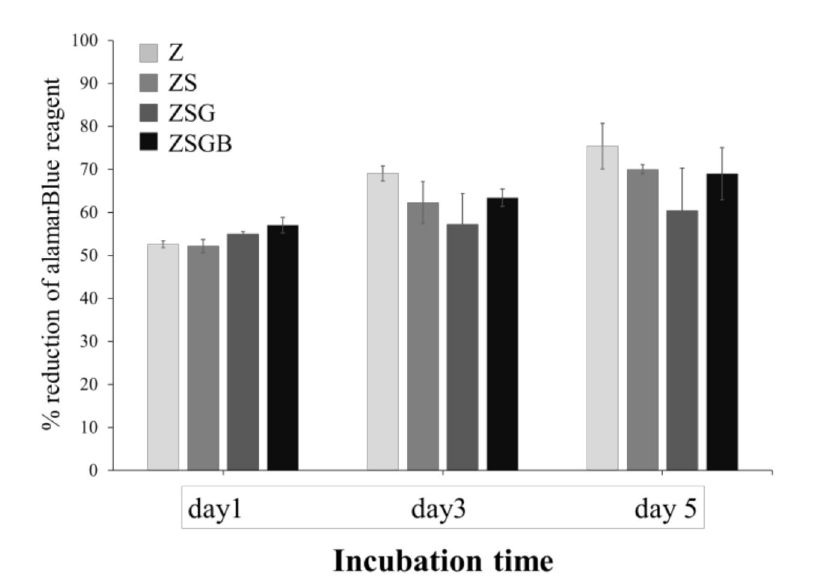
Figure 5. Cell proliferation of test specimens during the 5 d of